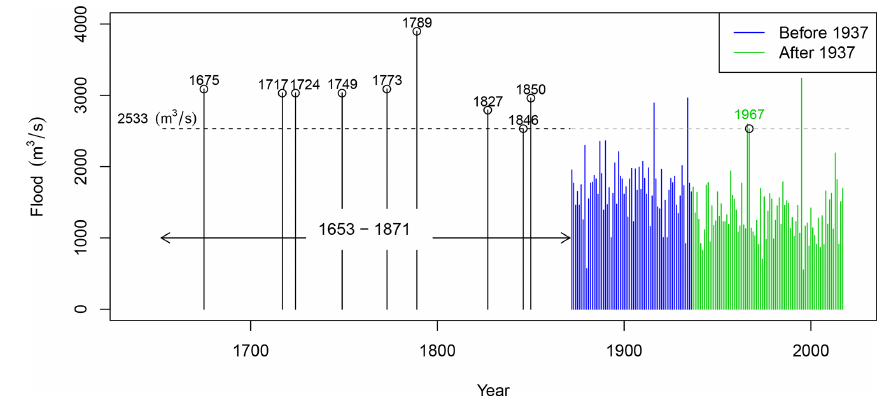
Figure 6. Systematic and historical flood data at Elverum. The systematic data from 1872 to 1936 were used for flood frequency analysis. After 1937, the floods are dampened by river regulations. The flood in 1967 reached 2533m 3 s − 1 and was used as a threshold for the historical floods. The period for historical floods lasted from 1653 to 1871. The CE1789 flood known as Stor-Ofsen in Norway stands out in this record.